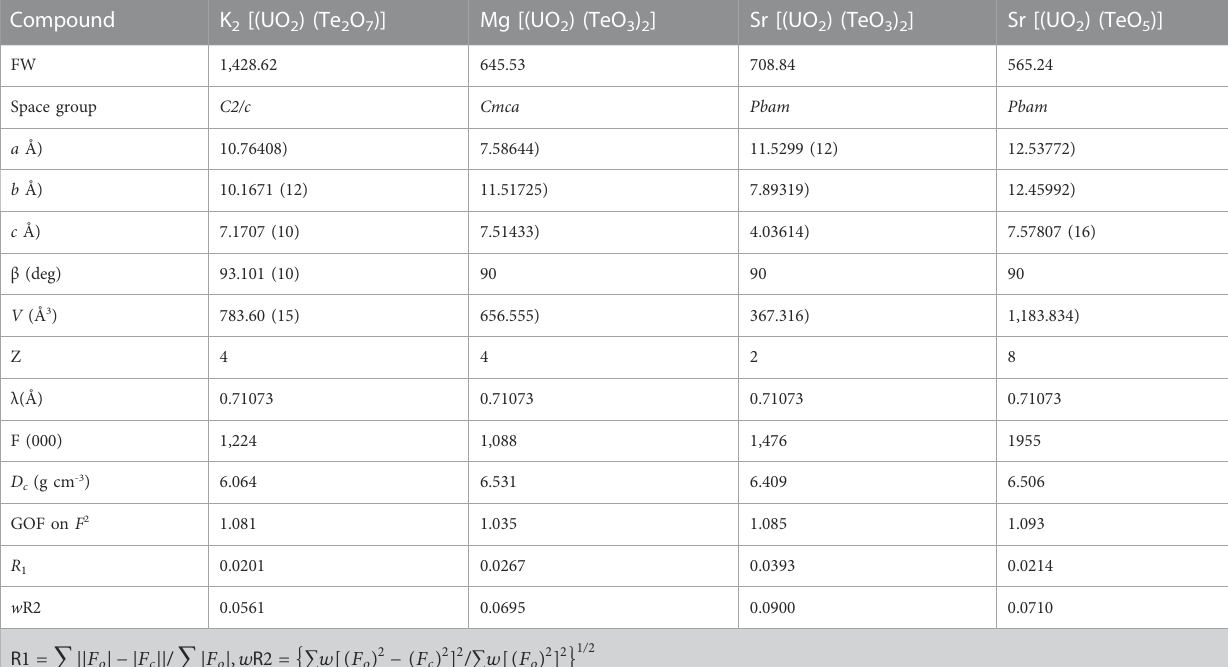
TABLE 1 Crystallographic data for K 2 [(UO 2 ) (Te 2 O 7 )], Mg [(UO 2 ) (TeO 3 ) 2 ], Sr [(UO 2 ) (TeO 3 ) 2 ] and Sr [(UO 2 ) (TeO 5 )].